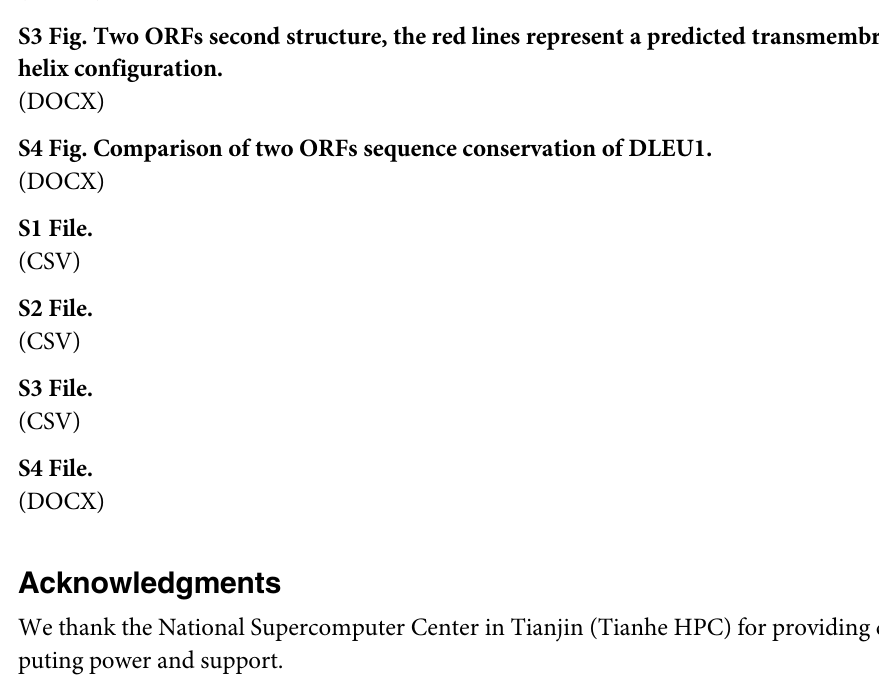
S1 Fig. The volcano of lncRNA, mRNA and miRNA. The red and green dots represent upre- gulate and downregulated RNAs respectively. S2 Fig. The predicted ORFs in WARS2.IT1 and DLEU1 lncRNA. The DLEU1 contain ORF1 and ORF8 can encoding small peptides. S3 Fig. Two ORFs second structure, the red lines represent a predicted transmembrane α - helix configuration. S4 Fig. Comparison of two ORFs sequence conservation of